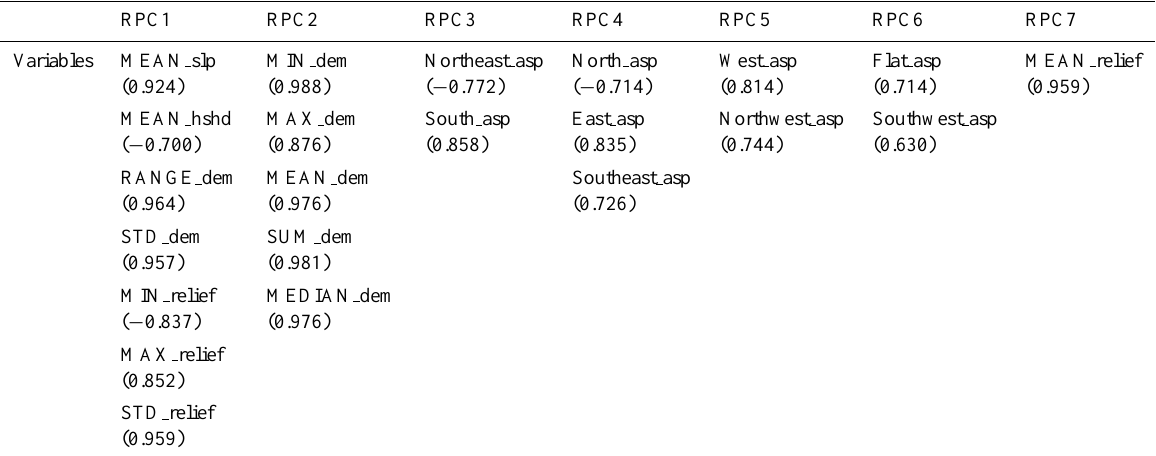
Table 5. Topographic variables represented by each RPC. Note that only variables with the most negative or the most positive loading values (i.e. absolute value > 0.6) are listed. The values are in the